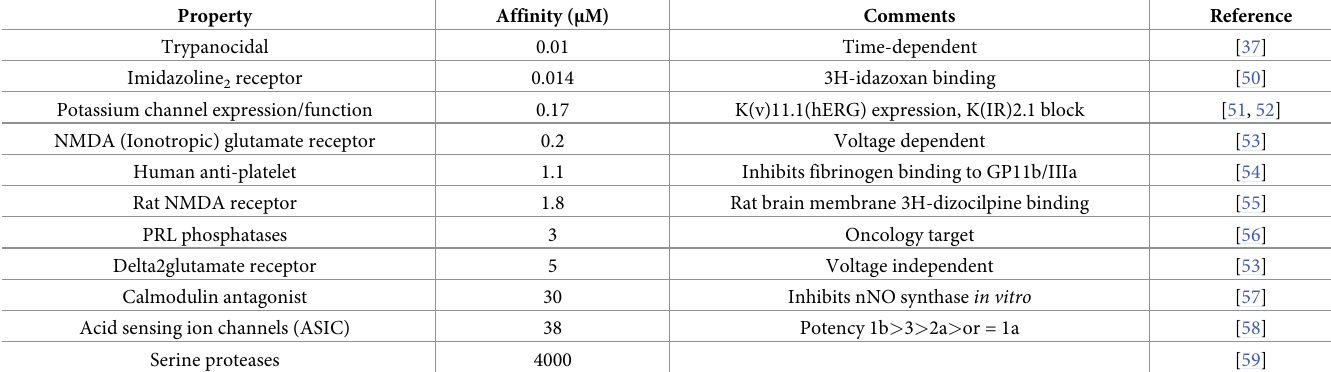
Table 2. Reported Pharmacology of Pentamidine in vitro . Property